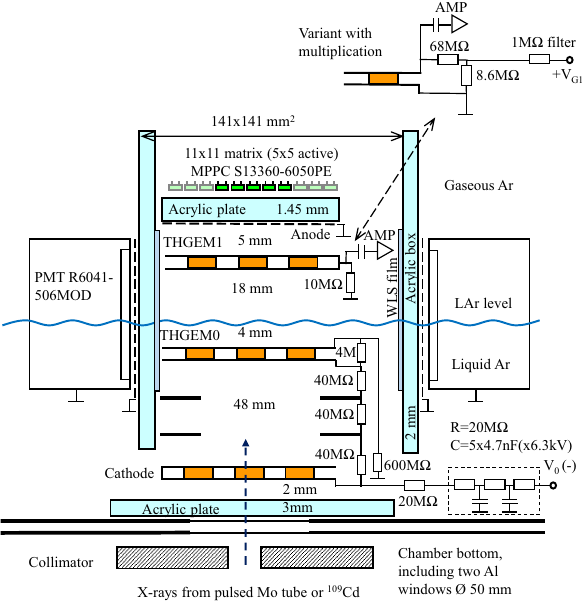
Fig. 8 Schematic view of the experimental setup. The electric fields lines in the TPC were presented elsewhere [34]